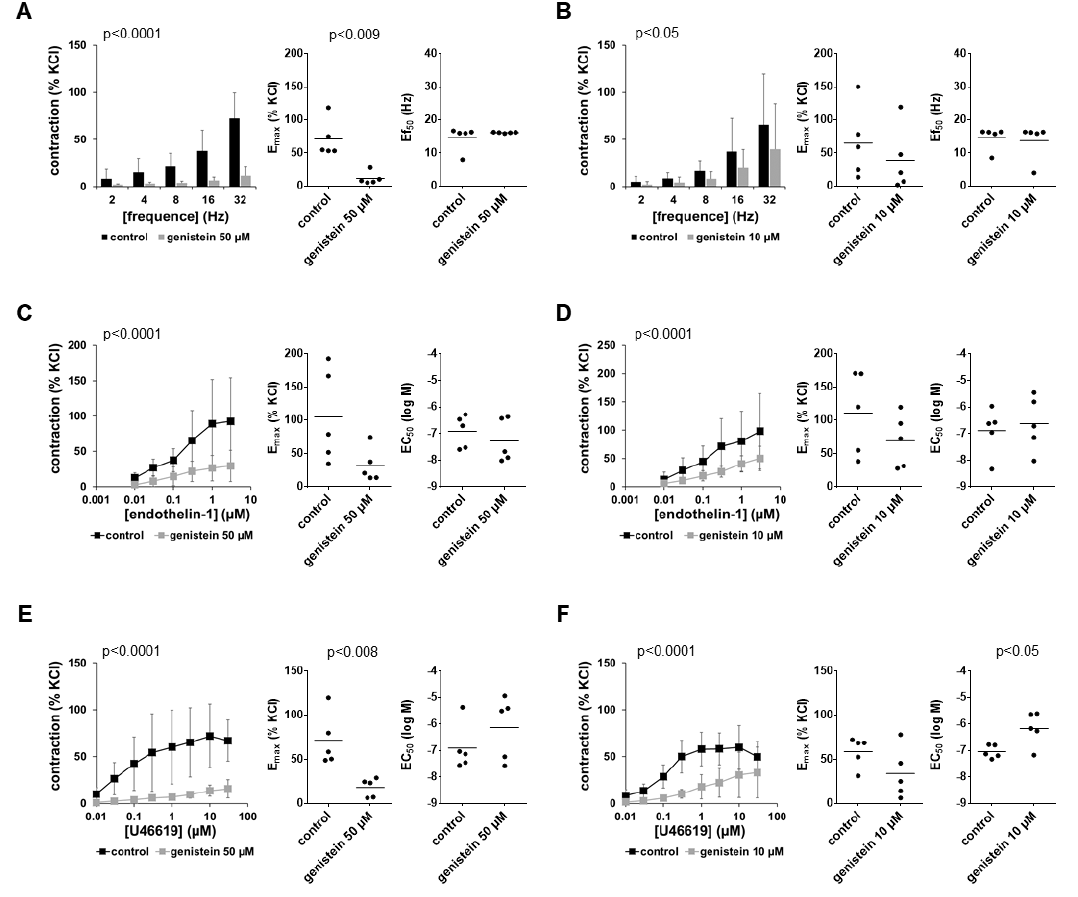
Figure 2. Effects of genistein on EFS-induced and non-adrenergic contractions of human prostate tissues. Contractions were induced by EFS ( A , B ), endothelin-1 ( C , D ) and U46619 ( E , F ) in the presence of 50 µ M genistein ( A , C , E ), 10 µ M genistein ( B , D , F ) and corresponding amounts of solvent (DMSO) for the controls added 30 min before the construction of frequency and concentration–response curves. Data from experiments with tissues from n = 5 patients are shown in each diagram. In each experiment, tissue from one patient was allocated to the control and genistein groups. Data are means ± SDs in frequency/concentration–response curves ( p -values for whole groups from two-way ANOVA), and E max , Ef 50 and EC 50 values are from all single experiments (calculated by curve